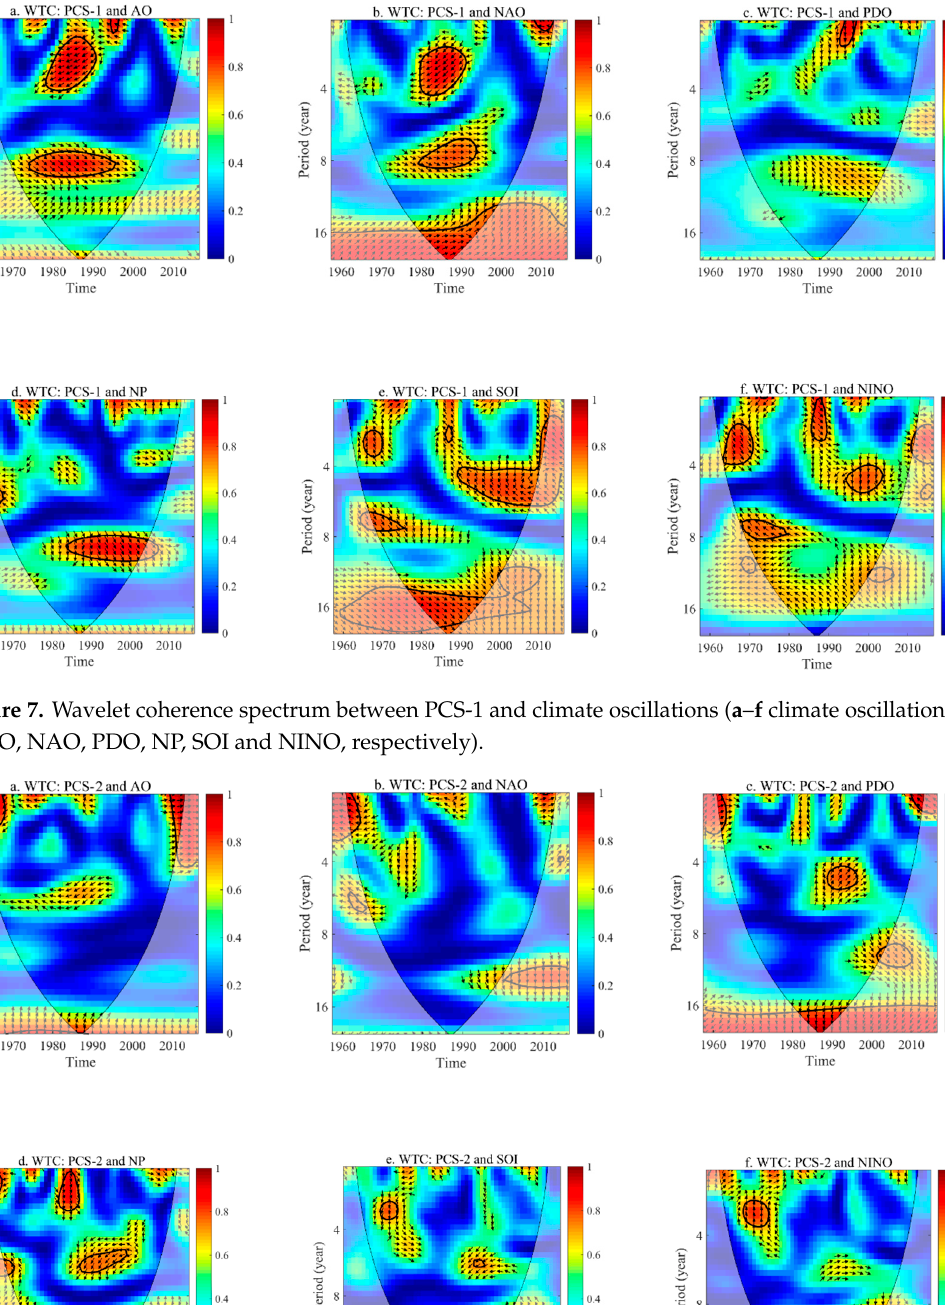
( f ) Figure 9. Wavelet coherence spectrum between PCS-3 and climate oscillations ( a – f climate oscillations of AO, NAO, PDO, NP, SOI and NINO, respectively). The second component explains 20.95% of the total variance and shows a spatial pattern of higher rotated principle component values in the northern area and lower values in the southern area